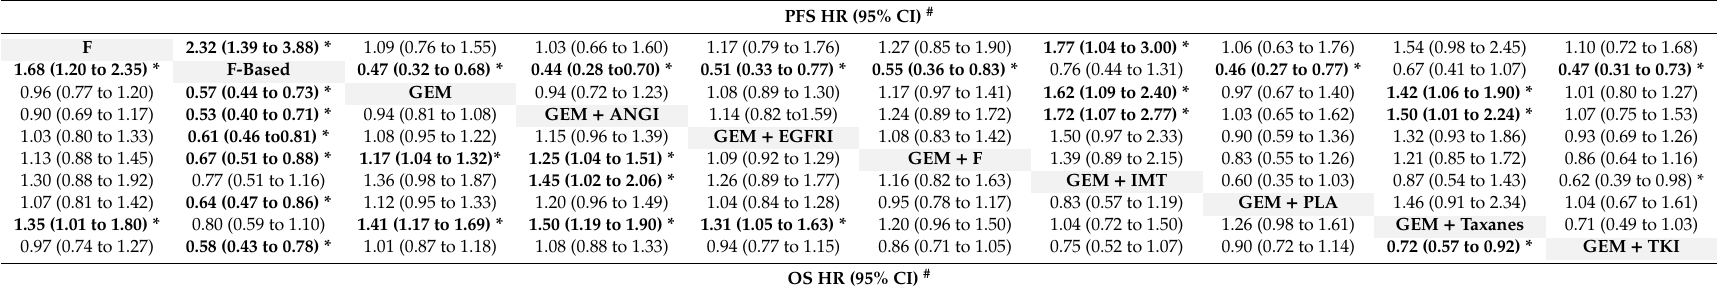
Table 1. Indirect comparison of overall survival and progression free survival. Results of indirect comparison of overall survival are presented in the left lower half, and results from indirect comparison of progression-free survival are presented in the upper-right half.